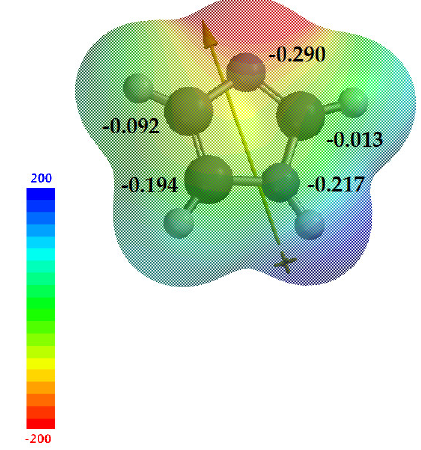
Figure 8. Electrostatic map of imidazole 1 , showing the natural charges of each atom and the dipole moment.